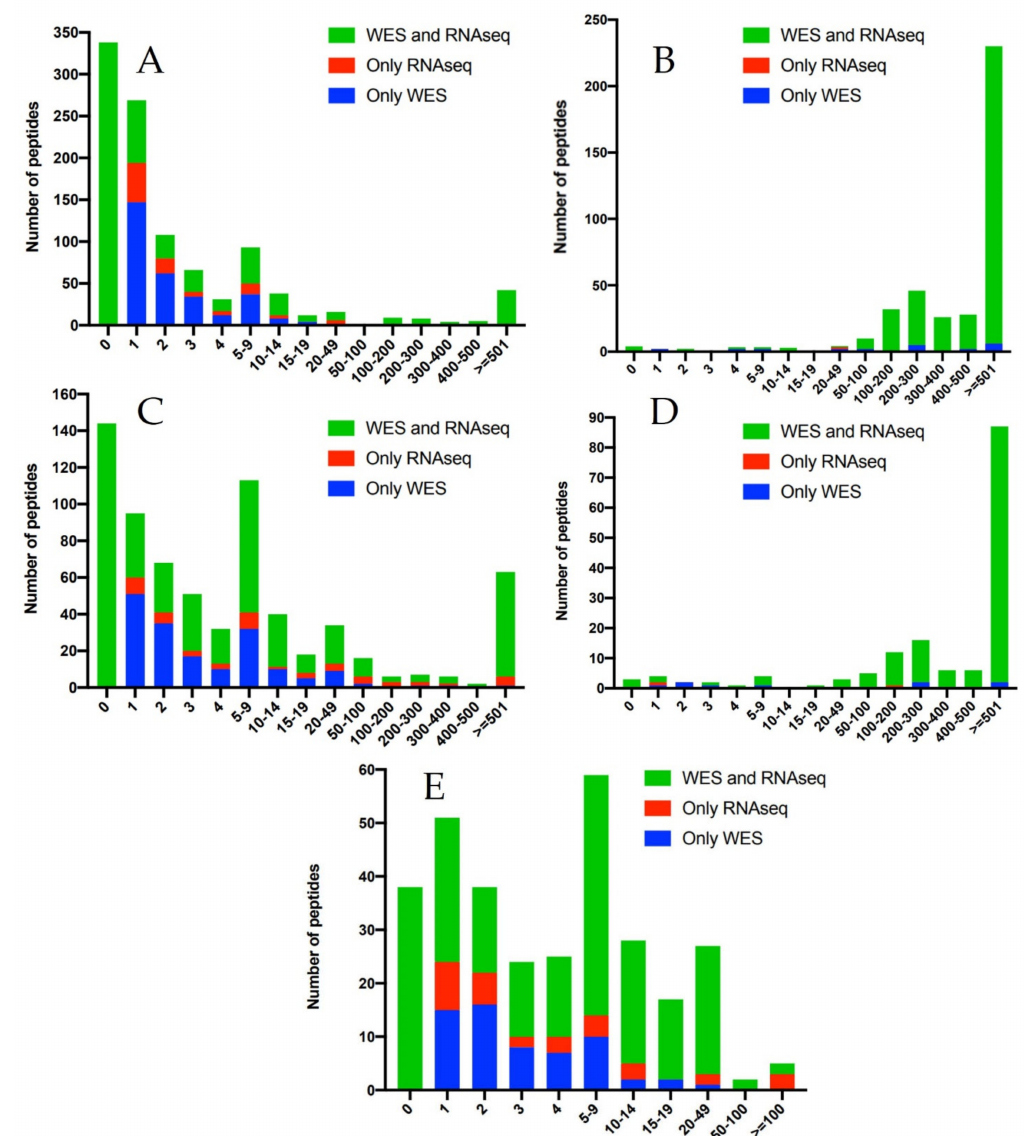
Figure 3. Distribution of the copy numbers observed with WES and RNAseq for the Bolt variant peptide IDs from the 02CPTAC TMT plex. The x -axis in all the plots is the genomic sequence copy number. ( A ) COSMIC variants that were not present in the CPTAC study; ( B ) COSMIC variants that were also identified in the CPTAC study; ( C ) dbSNP variants that were not present in the CPTAC study; ( D ) dbSNP variants that were also identified in the CPTAC study; and ( E ) novel missense variants that were not present in the CPTAC study. For all the plots, blue shows the copy number for the peptide IDs that were observed only in the WES data, red shows the copy number for the peptide IDs that were observed only in the RNAseq data and green shows the WES copy number for the peptide IDs that were observed with both WES and